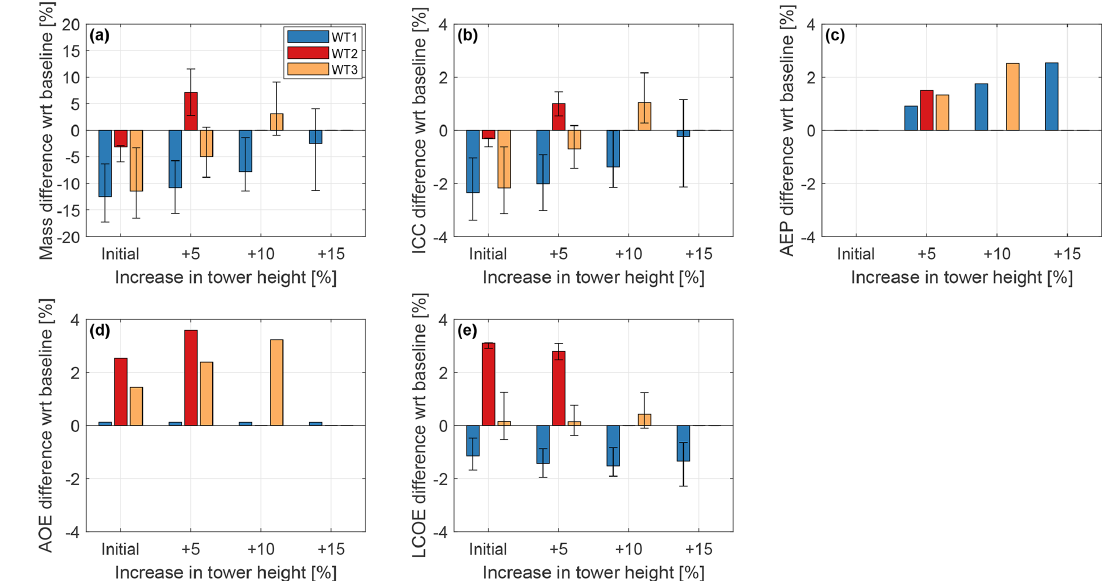
Figure 7. Effects of LAC on the redesign of towers of increasing height with respect to the initial non-LAC baselines. Solid bars: load- reduction model of Table 2; whiskers: range of the pessimistic and optimistic scenarios. The study considers increments of + 5%, 10%, and 15% in tower height for WT1; an increment of 5% in tower height for WT2; and increments of 5% and 10% in tower height for WT3.